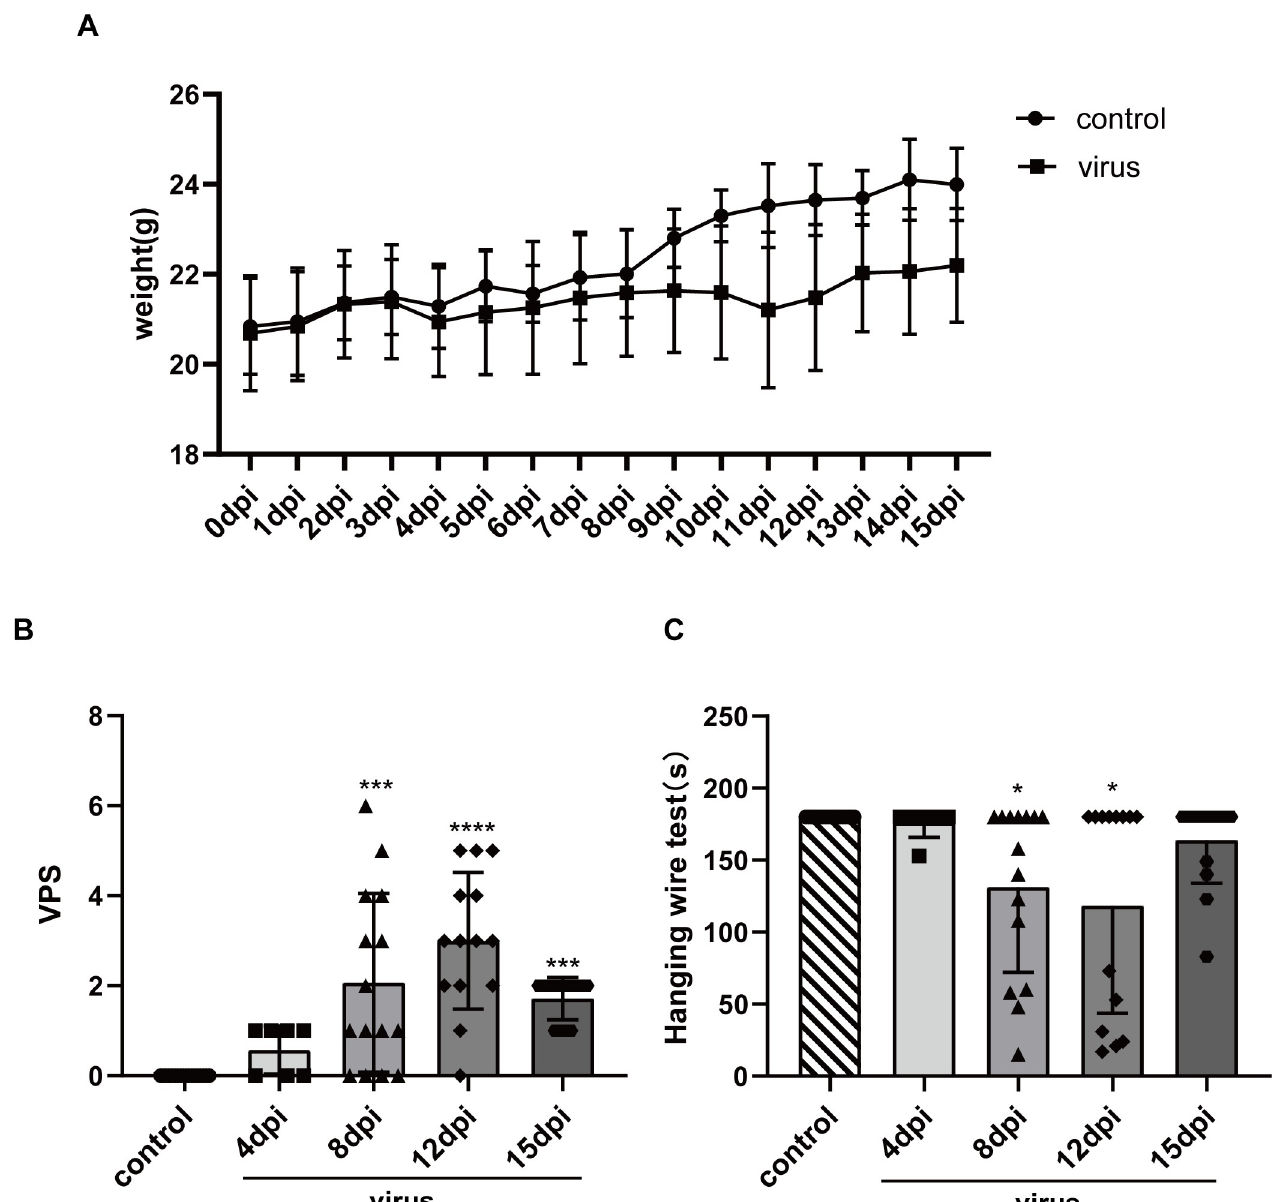
Fig 1. Behavioral changes of mice at different time. (A) Body weight change of the mice at different time; (B) VPS scores at different time. Kruskal-Wallis H test was used ( ���� p < 0.0001); (C) Hanging wire test at different time. Kruskal-Wallis H test was applied for statistical analysis ( �� p = 0.005). mice who fell on the first trial, occasionally stayed suspended on the wire mesh for 180s in the second or third trial of the day, but most mice fell all three times. Eight of 15 mice in the virus group spent less than 180s suspended on the wire mesh. At 12 dpi, the time the virus-exposed mice were able to suspend their bodies from the wire mesh also was significantly shorter ( � p = 0.0283). Six of 14 mice fell and the time they remained suspended was less than 80s. At 15 dpi (p > 0.9999), the amount of time the virus-exposed mice remained suspended on the wire mesh was longer than the average time observed at 12 dpi, and fewer mice fell (4/14) (Fig 1C).